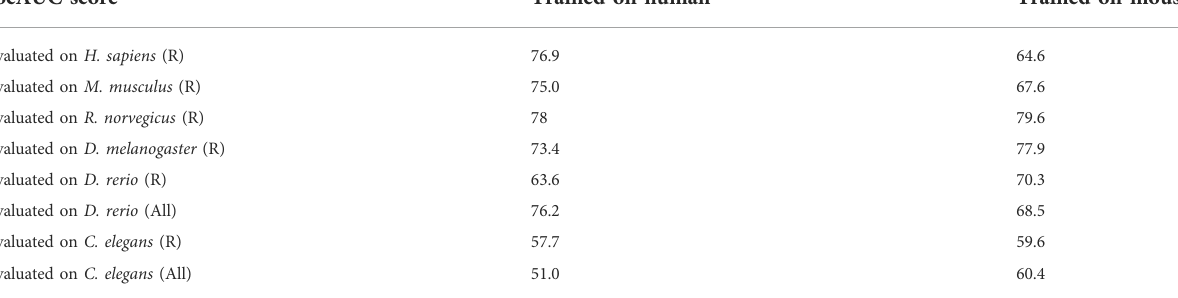
TABLE 2 miRNA predictions between